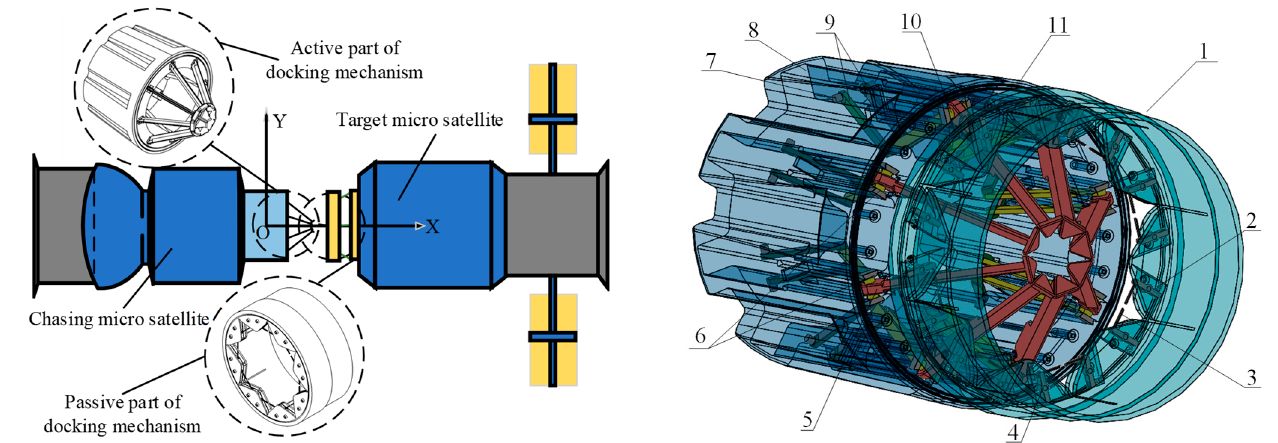
Figure 1. System composition of the deployable docking mechanism. 1—docking framework of